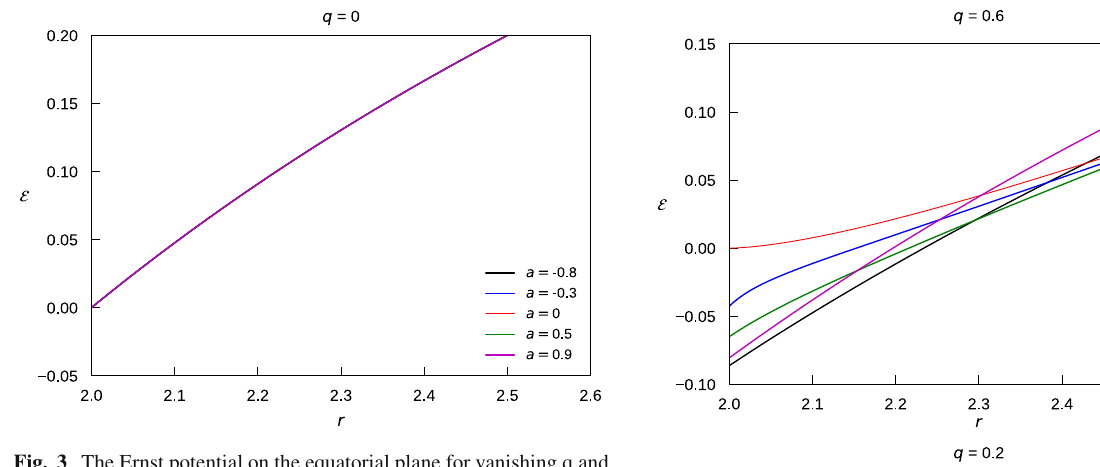
Fig. 3 The Ernst potential on the equatorial plane for vanishing q and different spin parameters a